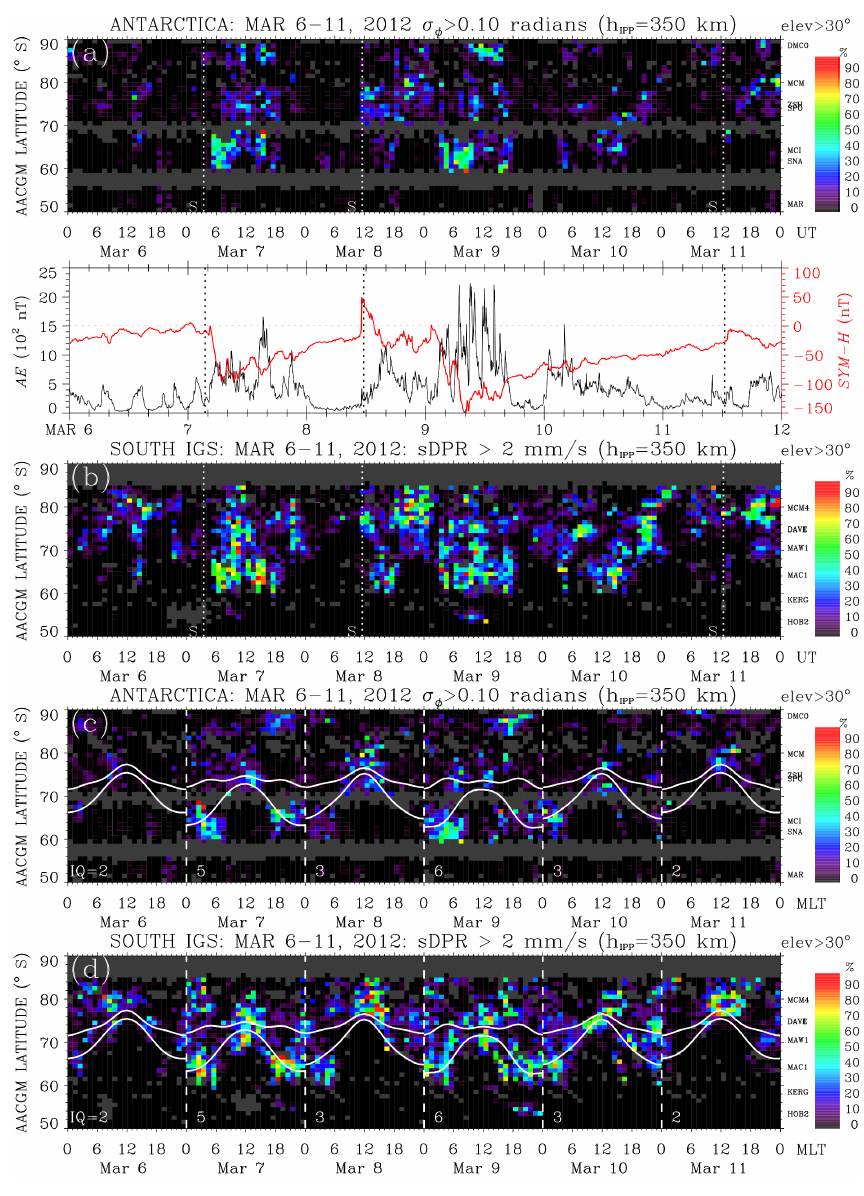
Figure 3. The occurrence of phase scintillation ( σ (cid:56) >0.1rad and sDPR>2mms − 1 ) as a function of AACGM latitude and (a, b) UT or (c, d) MLT in the Southern Hemisphere from 6 to 11 March. The dotted vertical lines in the top two panels indicate interplanetary shock arrival times. The dashed vertical lines separate days mapped in MLT. The IQ values of the statistical auroral oval are chosen to be approximately proportional to maximum 3-hourly Kp index. A panel showing provisional geomagnetic indices AE and SYM-H is inserted for convenience of